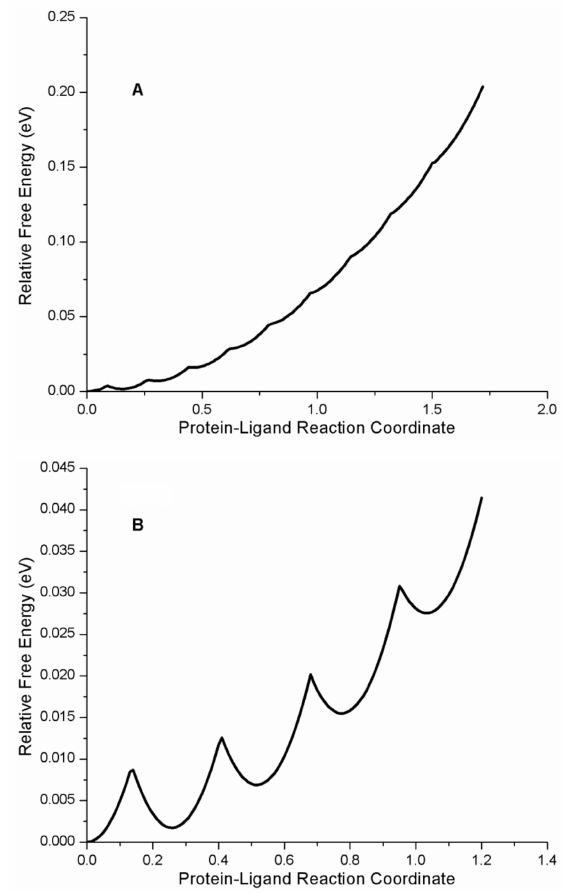
Figure 7. Free energy landscapes for AG1478-p38 α kinase and AG1478-APH2 derived from REES data. Vertical axes represents the free energy difference (relative to zero for the most stable state) in units of eV and horizontal axis is the protein–ligand reaction coordinate, x. ( A ) FEL for AG1478-p38 α kinase. ( B ) FEL for